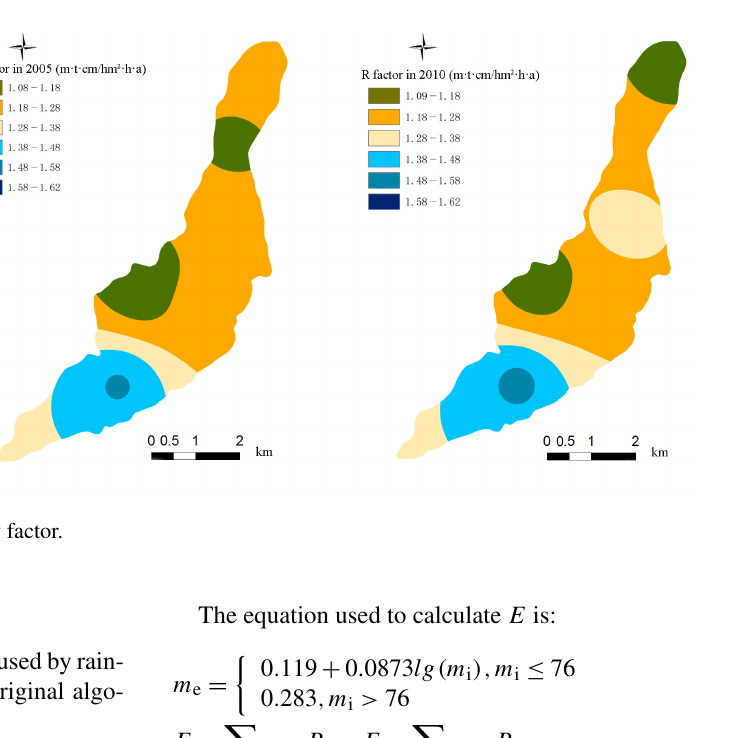
Figure 2. The distribution of rainfall and hydrologic stations.